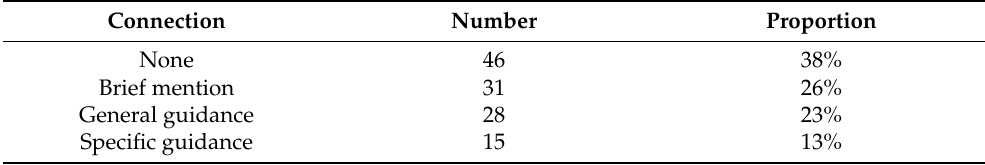
Table 2. Connections to applications and governance, in term of number of studies and proportion of total